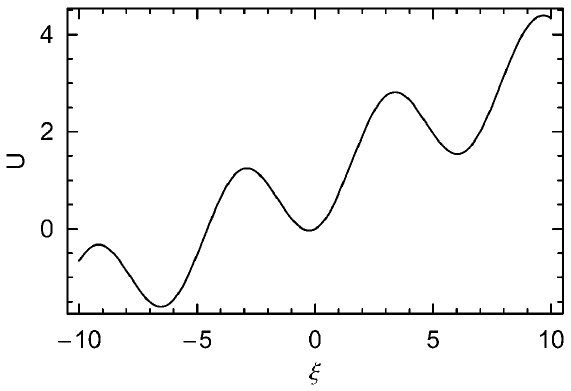
FIG. 5. Potential U (cid:1) ! + (cid:9) (cid:7) 1 (cid:3) cos + (cid:8) for ! (cid:1) 0 : 25 .